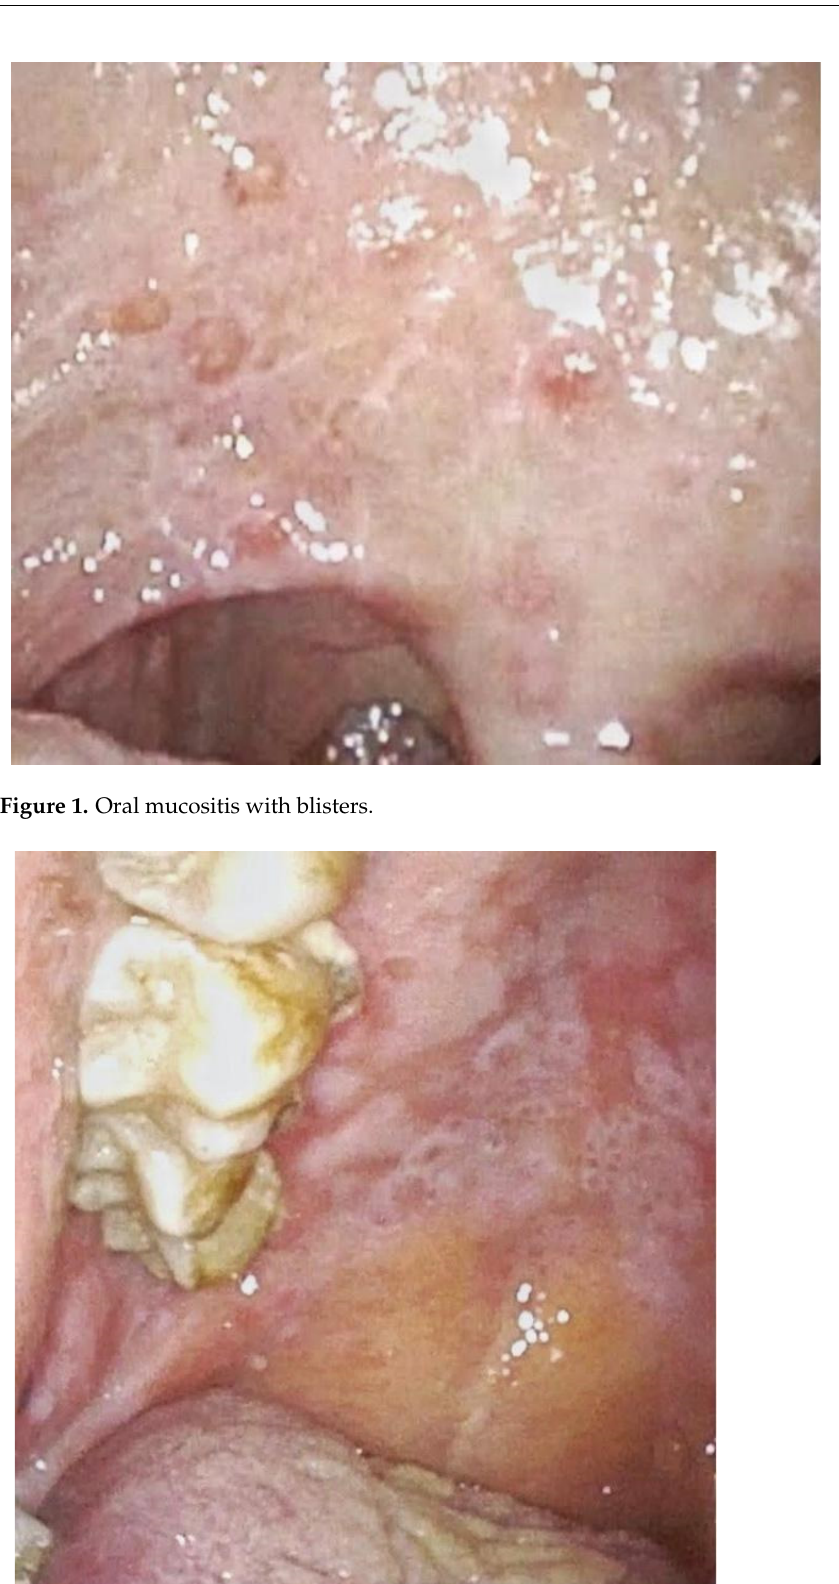
Figure 2. Leucoplakia of the hard palate with erosive spots and erythematous mucosa.